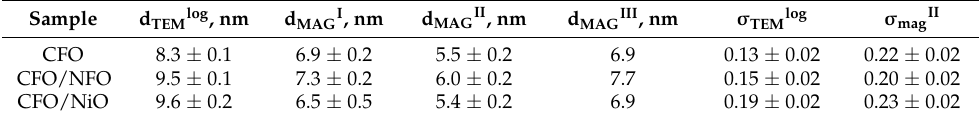
Table 3. Physical particle size determined from TEM analysis after log-normal fit (d TEMlog ), mag- netic size from the magnetic viscosity (d MAGI ), Langevin–Chantrell fit (d MAGII ) and MINORIM software (d MAGIII ), standard deviation of log-normal distribution of physical ( σ TEMlog ) and magnetic ( σ MAGII )